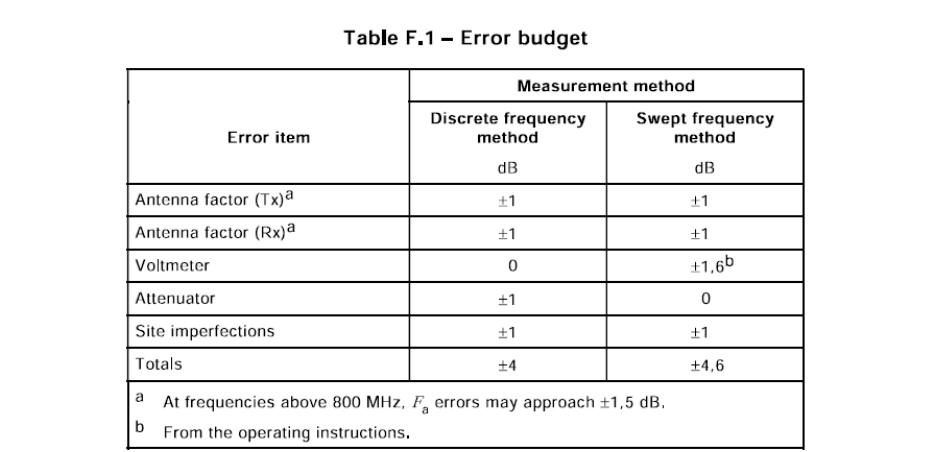
Figure 1. CISPR 16 1–4 site error description.